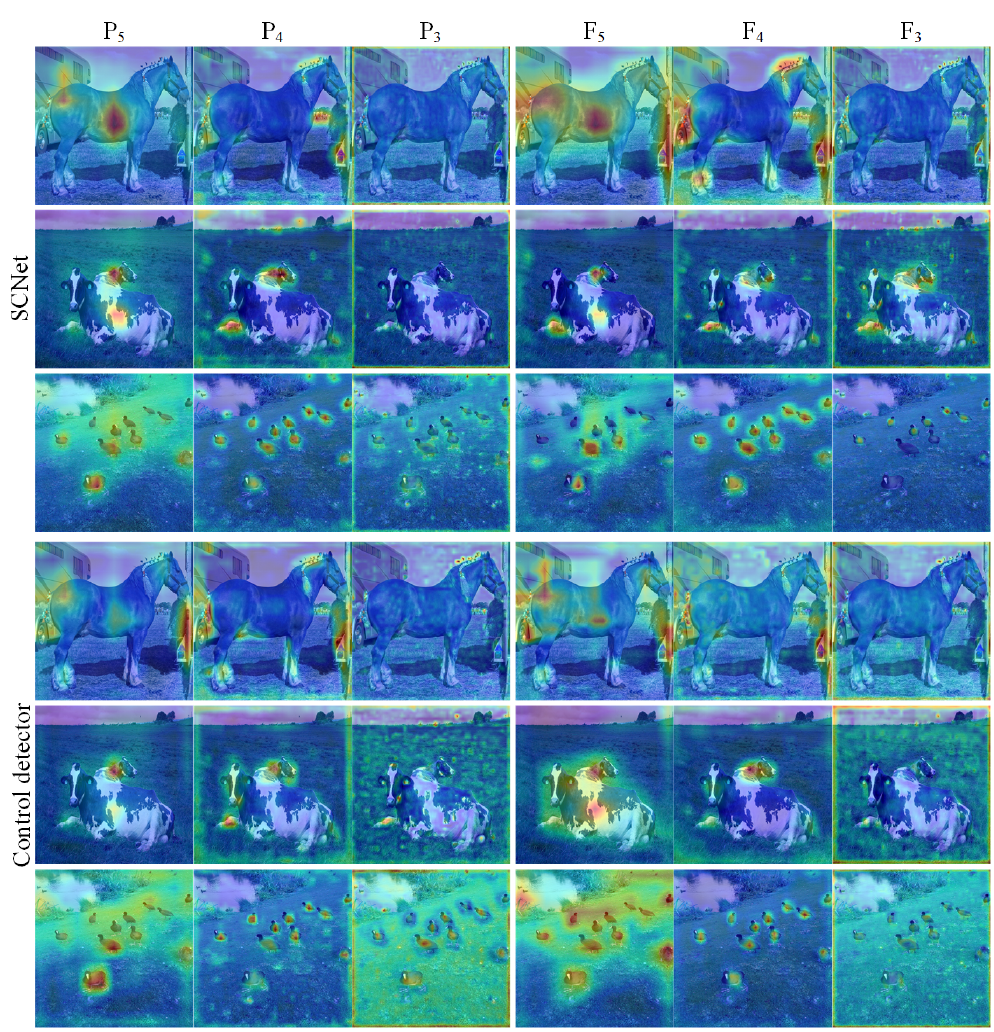
Figure 8. Heat maps of feature maps { P 3 , P 4 , P 5 , F 3 , F 4 , F 5 } , which are extracted from SCNet and a control detector. These detectors complete the network training under the same conditions and tricks to achieve fair comparisons.